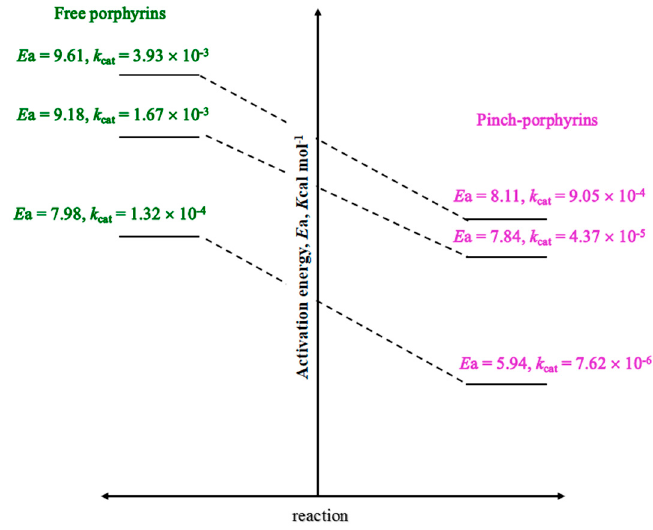
Figure 9. Comparison of the activation energies from three compounds with and without the pinch- axial-ligand.